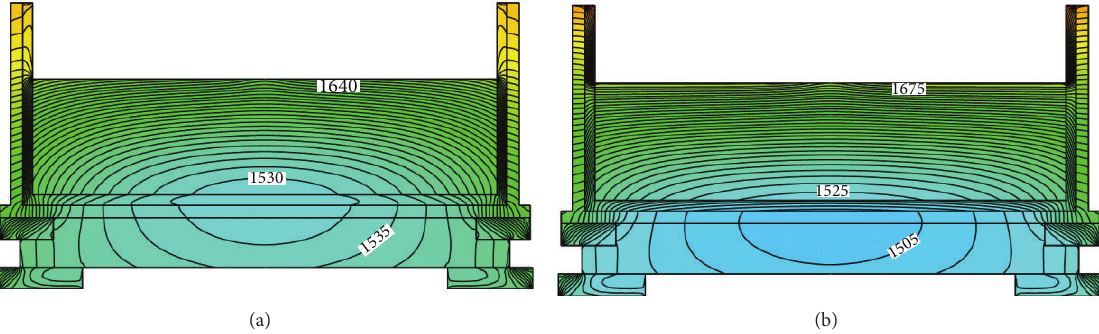
Figure 5: Temperature distribution (5K between two isotherms) before melting of feedstock in conventional DS furnace for different power distribution ratios: (a) 5 :5; (b) 10:0.